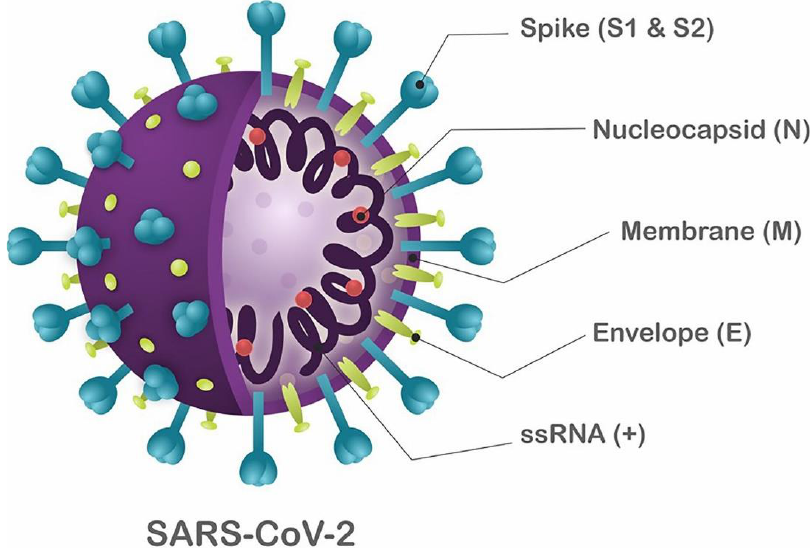
Figure 1. Schematic structure of SARS-CoV-2. The viral structure is primarily formed by structural proteins, such as spike (S), membrane (M), envelope (E), and nucleocapsid (N) proteins. The S, M, and E proteins are embedded in the viral envelope, a lipid bilayer derived from the host cell membrane. The N protein interacts with the viral RNA in the core of the virion. Adapted with permission from ref. [32], published by Frontiers, 2020.